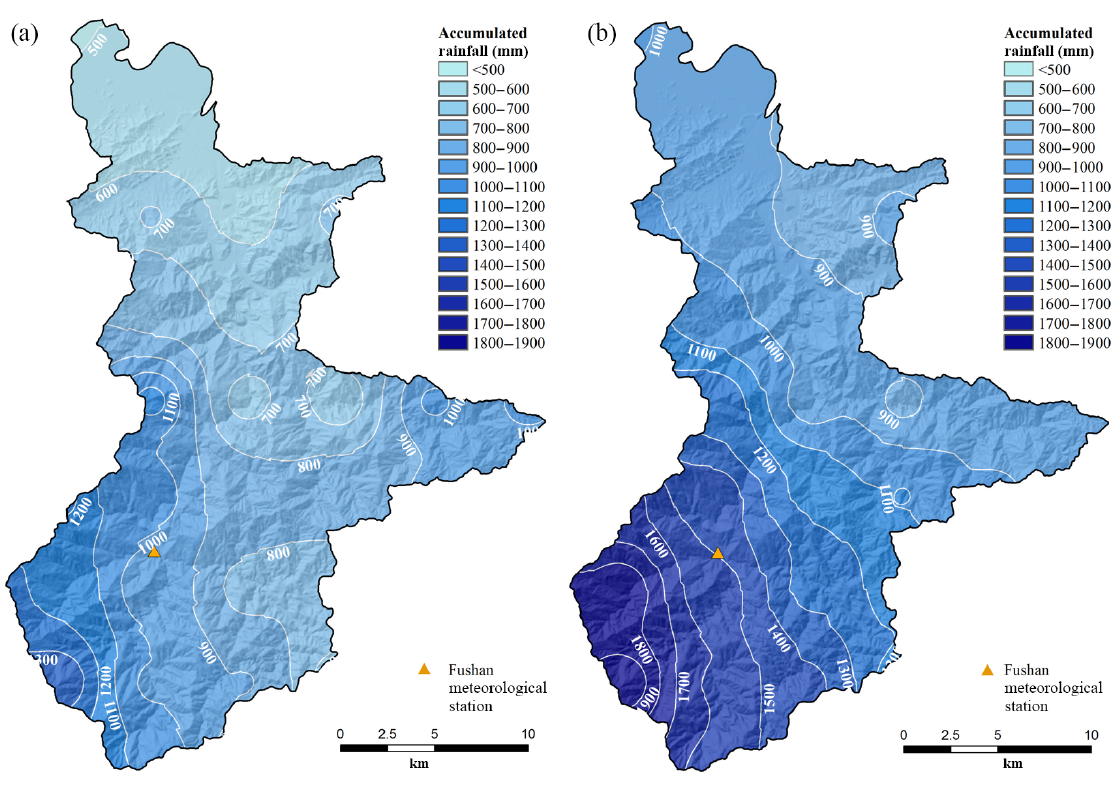
Figure 6. Accumulated rainfall distribution ( a : rank 1 rainfall of the late 20th century, b : rank 1 rainfall of late 21st